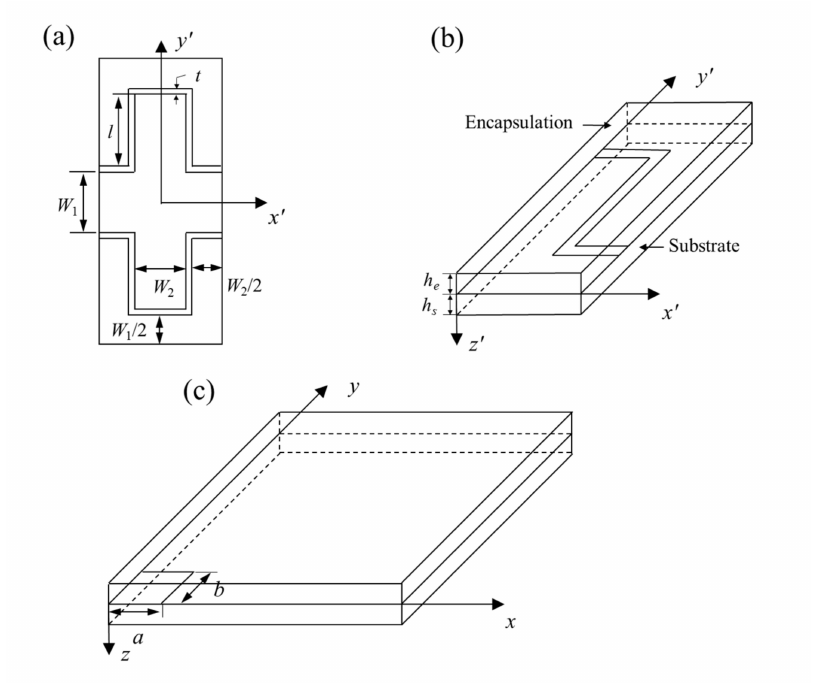
Figure 2. Schematic diagrams of ( a ) a single period and ( b ) a quarter of the model; ( c ) a rectangle heat source embedded in a quarter of the model with infinite size in the